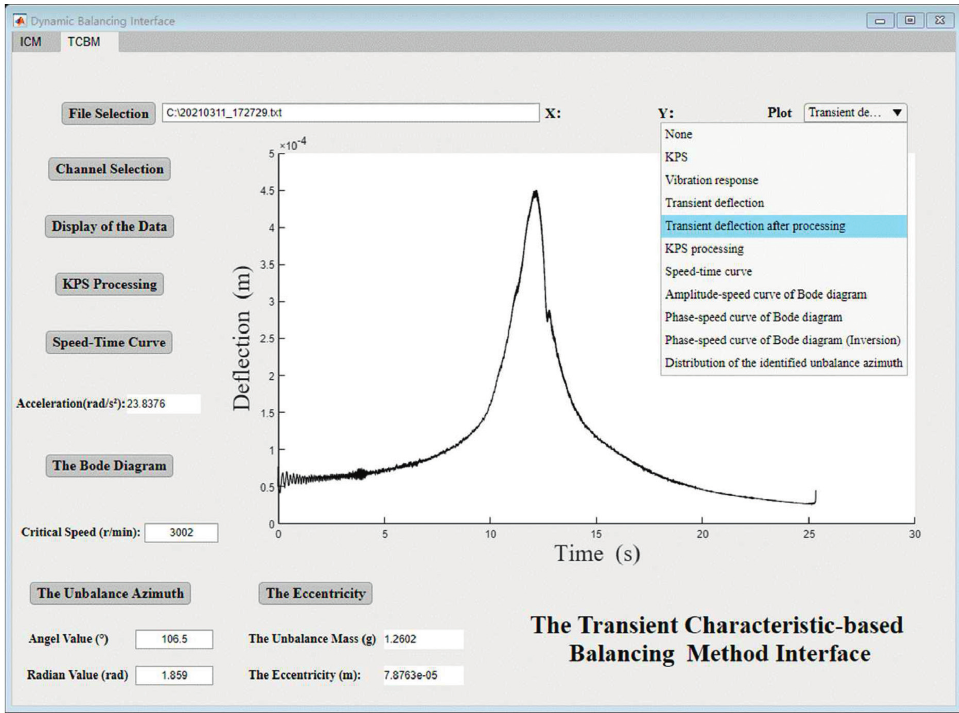
Figure 14: The results of the unbalance parameters identified by the TCBM